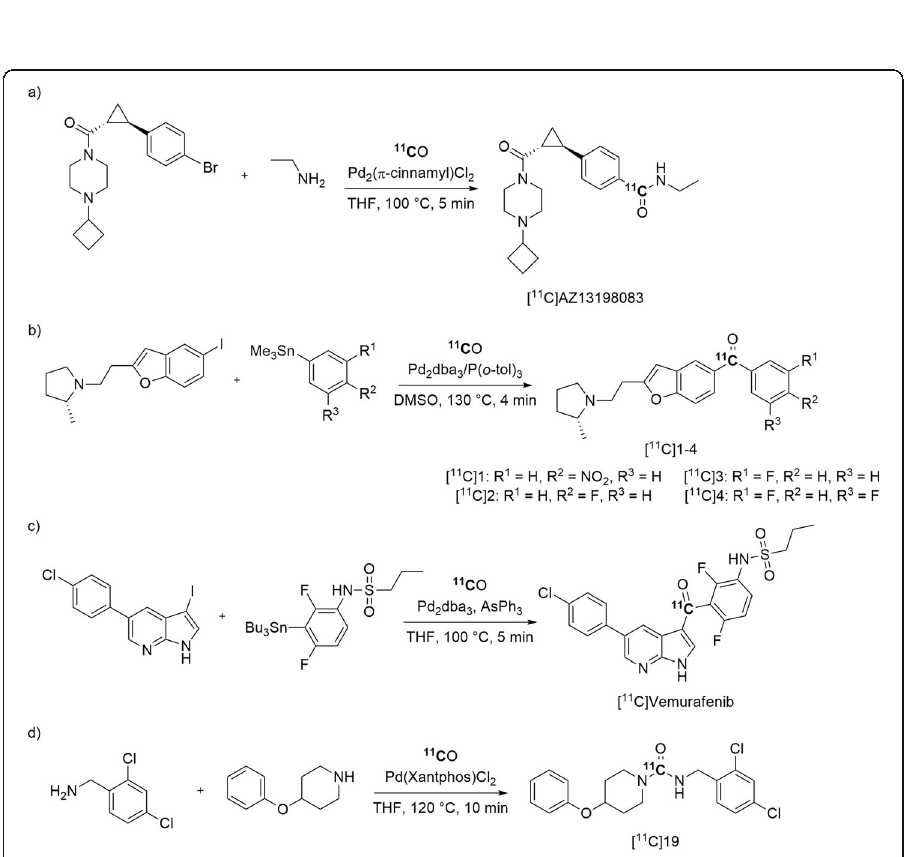
Fig. 27 Synthesis of potential H 3 R radiotracers: a [ 11 C]AZ13198083; b [ 11 C]1 – 4; c 11 C-labeling of [ 11 C]vemurafenib; and d of an sHE inhibitor [ 11 C]19 through Pd-mediated 11 C-carbonylation